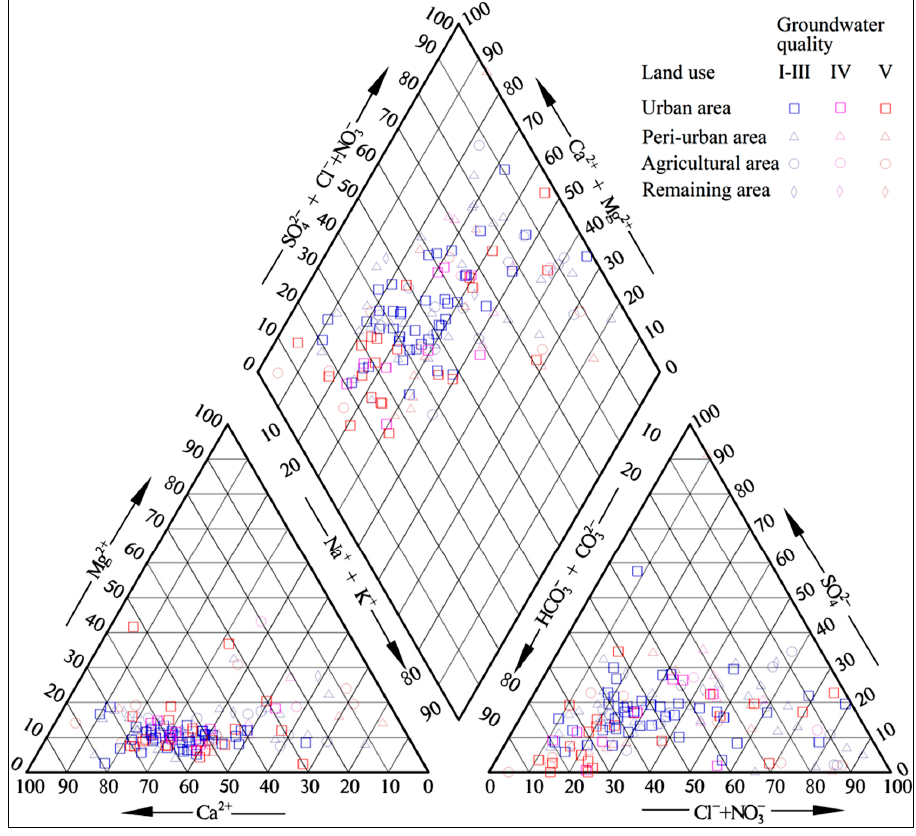
Figure 3. Hydrochemical facies of groundwater in areas with different types of land use of the coastal alluvial aquifer.